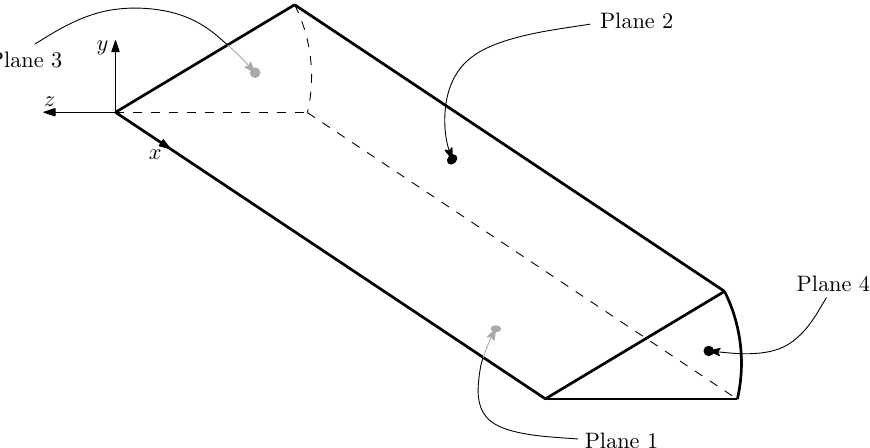
Figure 12. Description of the model. Plane 3 represents the eventual plane of failure; displacement is imposed in direction of the x axis on plane 4.